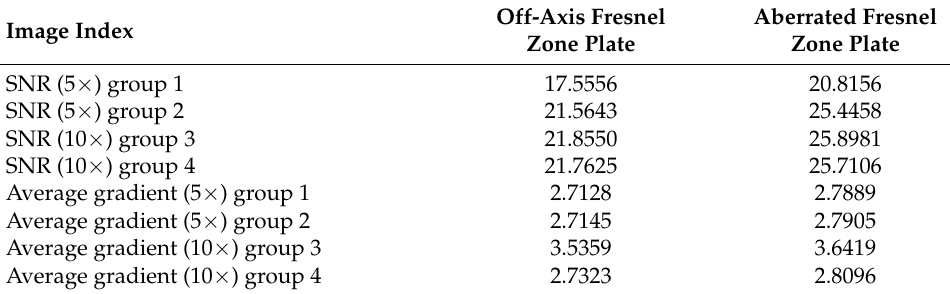
Figure 16. Results of experiment using chromatography microscopy with 10× objective lens with: ( a , b ) Off-axis Fresnel zone plate; ( c , d ) aberrated off-axis Fresnel zone plate. Table 5. Laminar microscopy optical path image index.